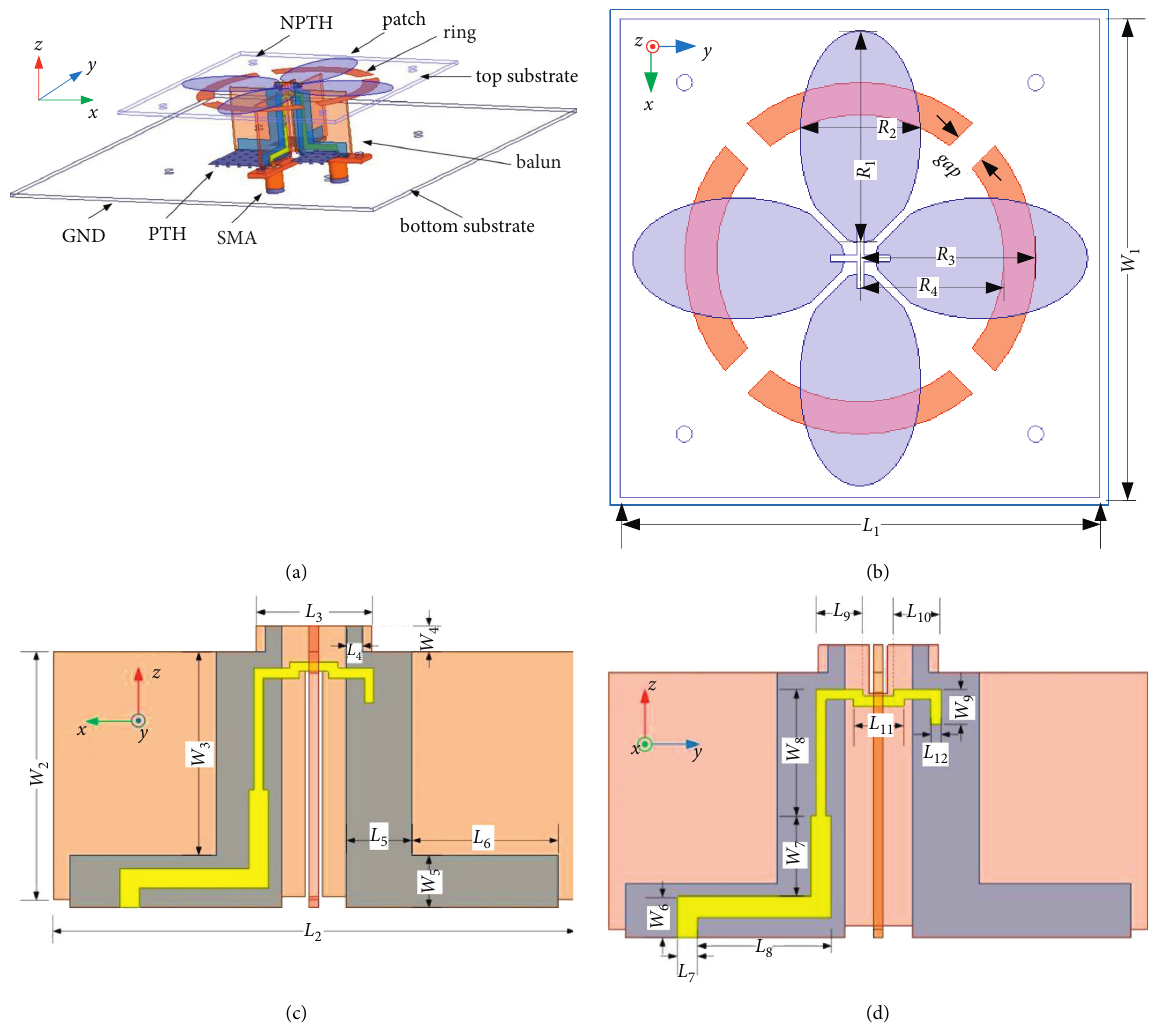
Figure 1: Geometry of the proposed antenna. (a) Perspective view, (b) the major radiator (two pairs of bowtie patches and an SR), (c) the balun structure in the xoz plane, and (d) the balun structure in the yoz